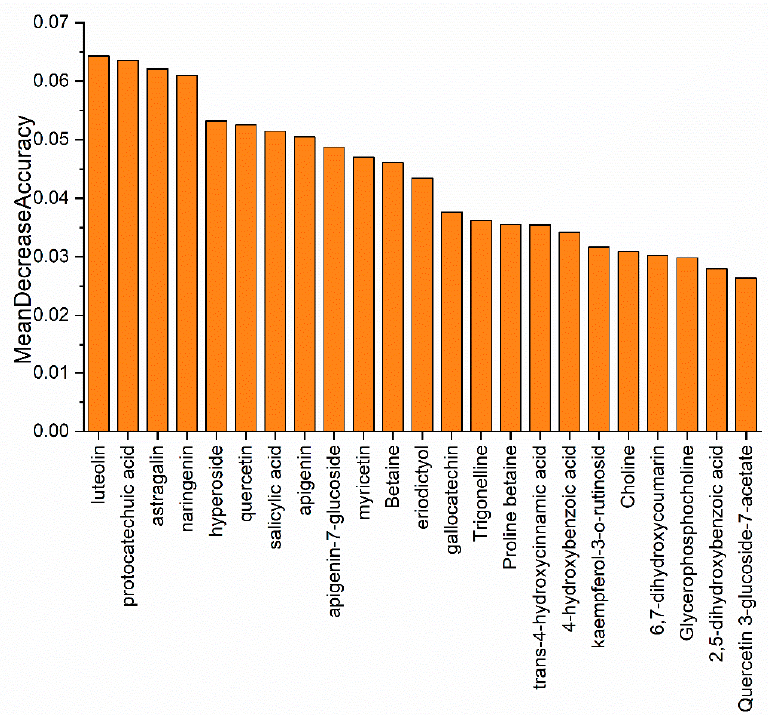
Figure 7. The relative importance of each variable in the random forest model and the importance of each variable is evaluated by the method of mean decrease accuracy.